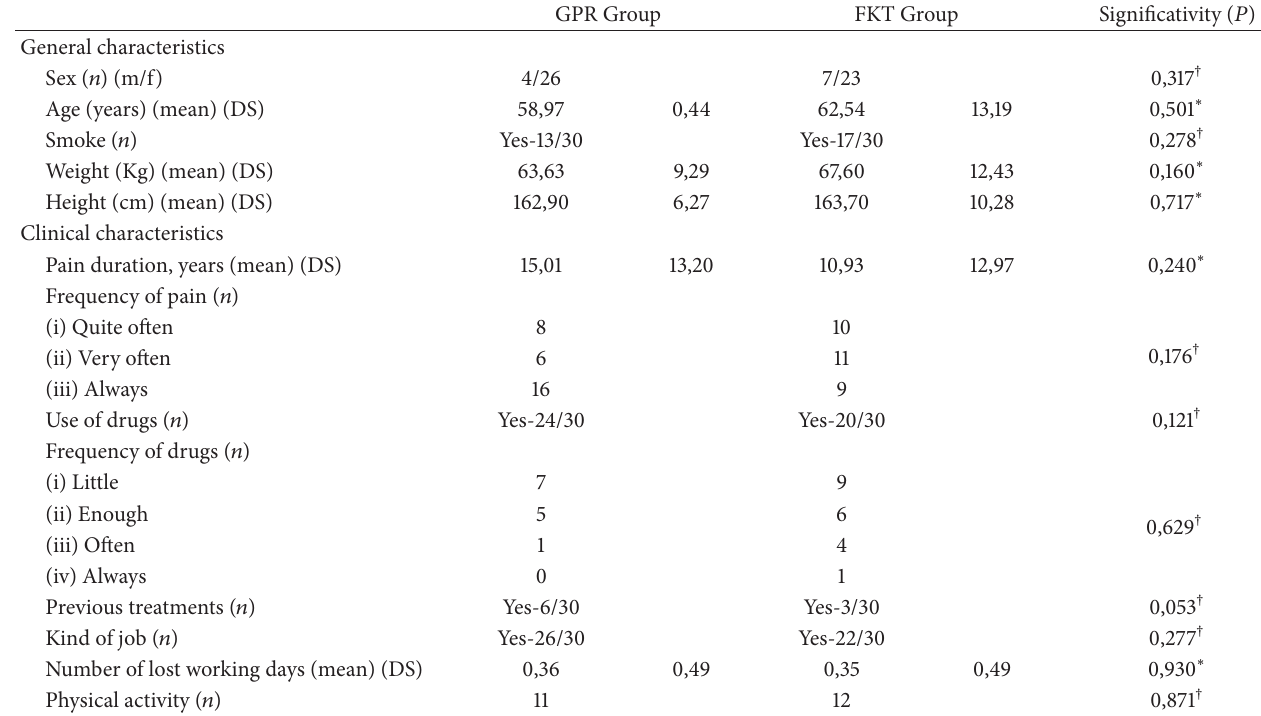
Table 1: Patients Characteristics at baseline.